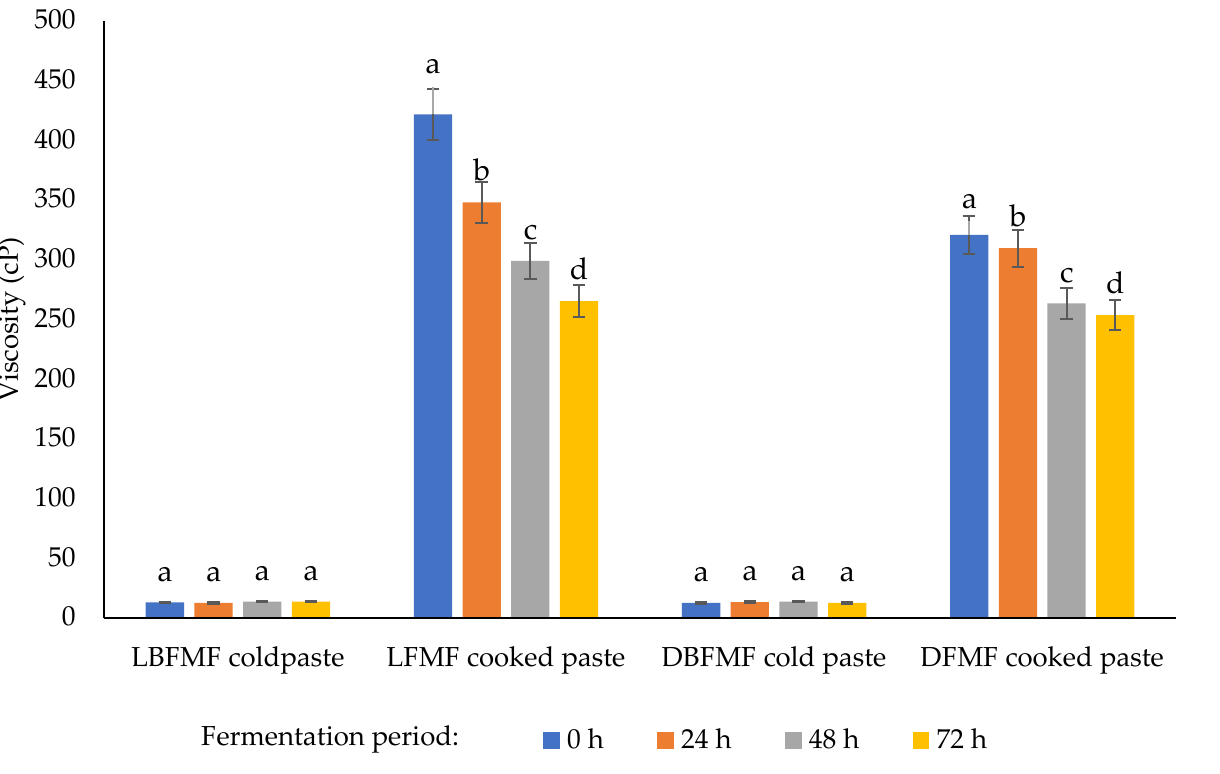
Figure 1. Influence of spontaneous fermentation on cold paste and cooked paste of finger millet flours. Different letters show statistically different effects ( p < 0.05). LBFMF = light-brown finger millet flour; DBFMF = dark-brown finger millet flour.